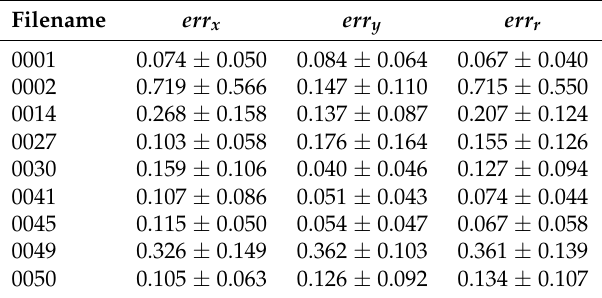
Figure 6. Radius estimation ± standard deviation for samples with the highest estimation variance. Table 1. Estimation mean error and standard deviation for target center ( x , y ) coordinates and radius for some samples in the